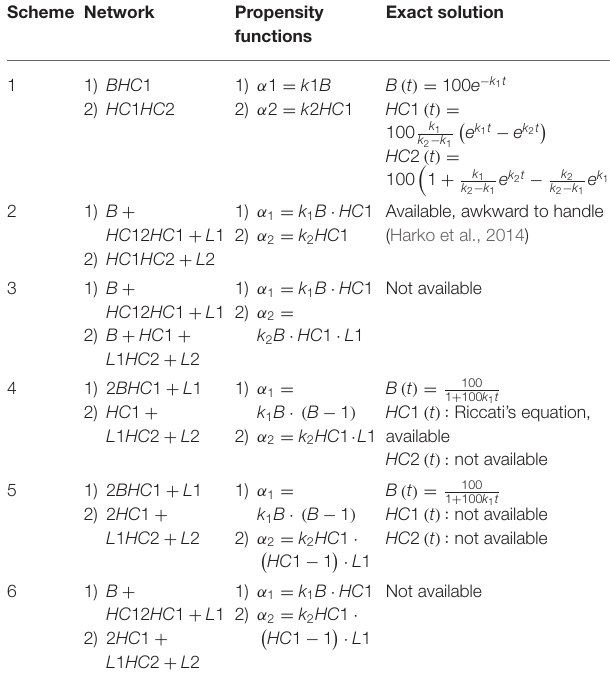
TABLE 4 | Model networks tested with program